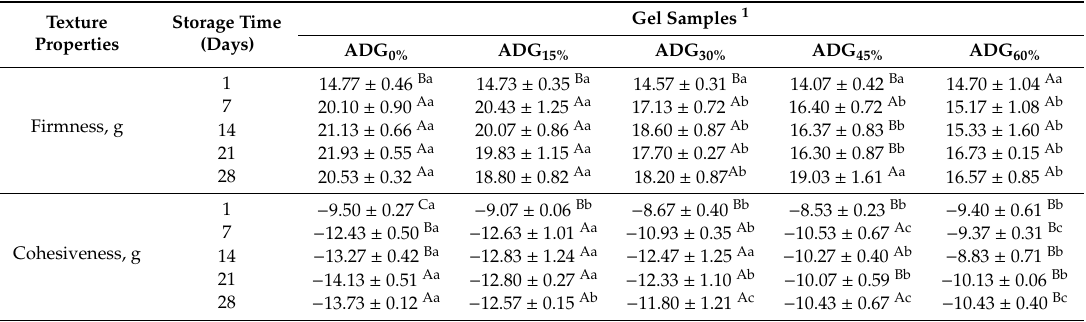
Table 2. Texture characteristics of stirred gel